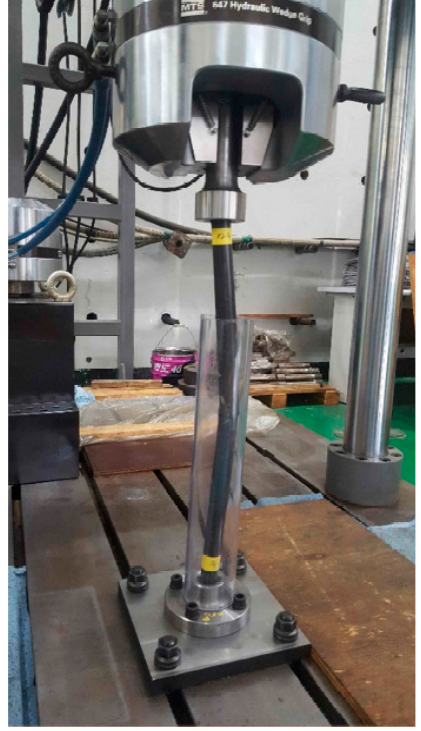
Figure 7. Experimental analysis of the test sample.